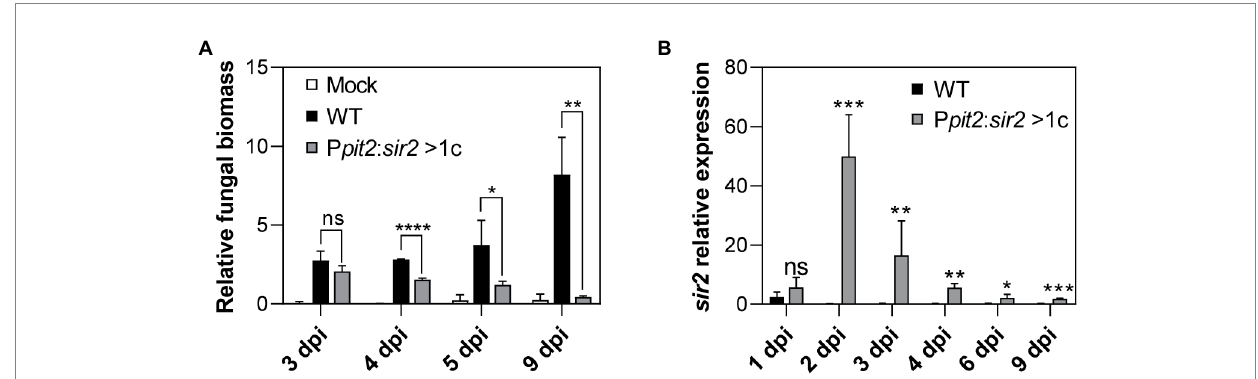
FIGURE 4 Progression inside the plant is impaired by the overexpression of sir2 . (A) Relative fungal biomass was calculated by comparison between U. maydis ppi1 gene and Z. mays glyceraldehyde 3-phosphate dehydrogenase gene (GAPDH), measured by RT-qPCR of genomic DNA extracted from leaves infected with wild-type and P pit2 : sir2 > 1c mutant at 3, 4, 5, and 9 dpi. Error bars represent the standard deviation from three independent replicates. Student’s t-test statistical analysis was performed (ns, not significant, * p -value < 0.05, ** p -value < 0.005, **** p -value < 0.0001). (B) sir2 expression of U. maydis wild-type and P pit2 : sir2 > 1c infecting maize leaves at 1, 2, 3, 4, 6, and 9 dpi, measured by RT-qPCR. U. maydis ppi1 was used as reference gene. Values were normalized to wild-type. Error bars represent the standard deviation from at least three independent replicates. Student’s t-test statistical analysis was performed (ns, not significant, * p -value < 0.05, ** p -value < 0.005, *** p -value <